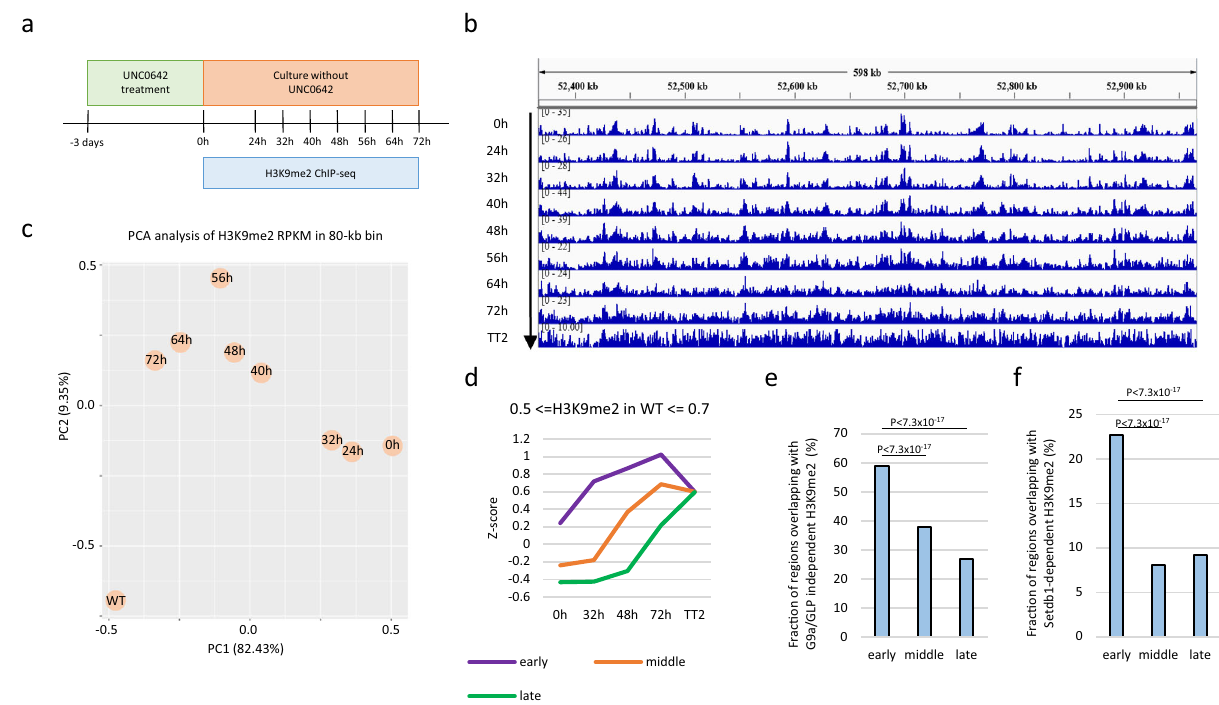
Fig. 3 Recovery of H3K9me2 after the UNC0642 treatment. a An experimental design to investigate H3K9me2 recovery. mESCs were treated with UNC0642 for 3 days, and then H3K9me2 ChIP-seq was performed at each time point after the UNC0642 removal. b A representative view of H3K9me2 ChIP-seq data during H3K9me2 recovery. c A principal component analysis of H3K9me2 ChIP-seq data during H3K9me2 recovery. d Distinct kinetics of H3K9me2 recovery from UNC0642 treatment between three classes of sequences. Each 10-kb region throughout the genome was classi fi ed into three types named “ early ” , “ middle ” , and “ late ” based on the timing of H3K9me2 recovery. Z-scaling was performed on H3K9me2 RPKM of 10-kb bins at each time point. Y axis represents the average Z scores of each class. Only regions with Z scores between 0.5 and 0.7 in WT mESCs were used for this analysis to match the fi nal H3K9me2 levels among three classes. e , f Overlap between G9a/GLP-independent H3K9me2 domains ( e ) or SETDB1-dependent H3K9me2 domains ( f ) and each class. Signi fi cant enrichment of G9a/GLP-independent or SETDB1-dependent H3K9me2 in early class was calculated by hypothesis testing for the difference in the population proportions using a function of prop.test by